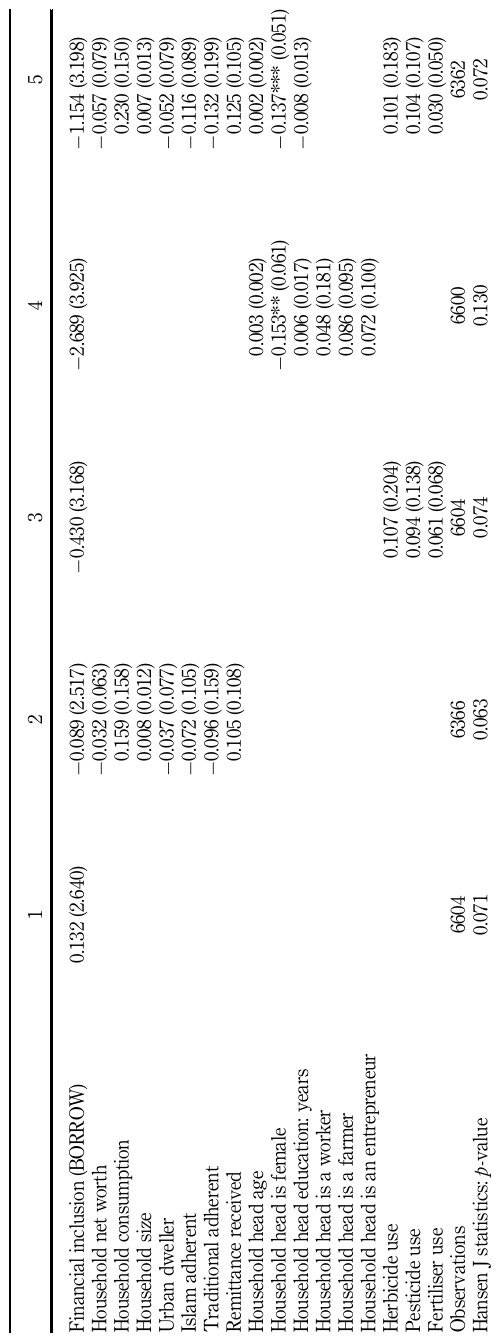
Table 4. Effects of financial inclusion (BORROW) on agricultural productivity – Instrumental variable